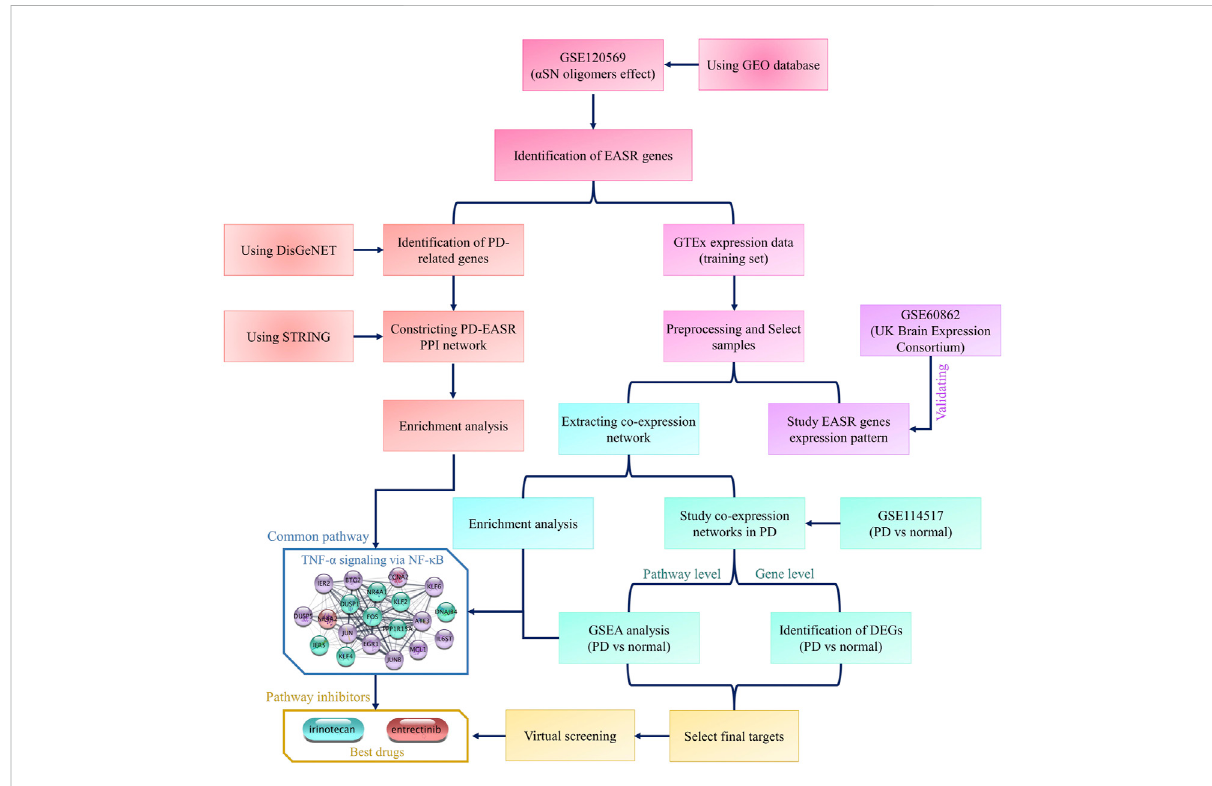
FIGURE 1 Flowchart of this study. The fl owchart represents all datasets and analyses that were used in the